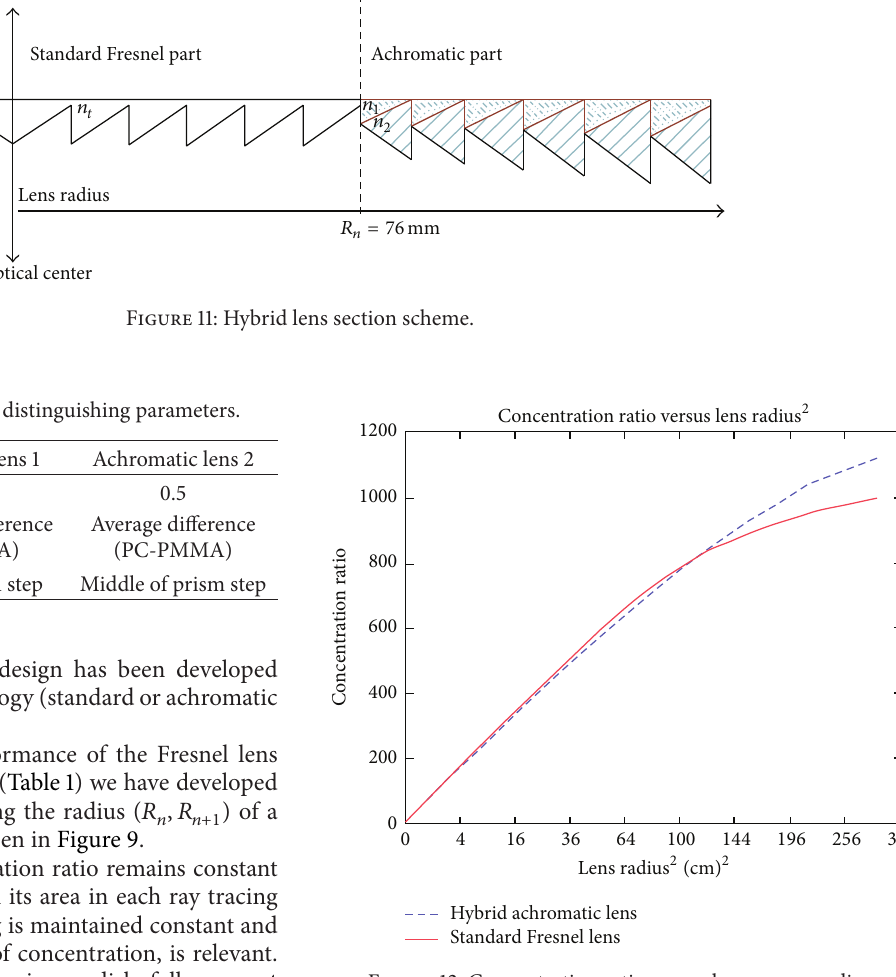
Figure 12: Concentration ratio versus lens square